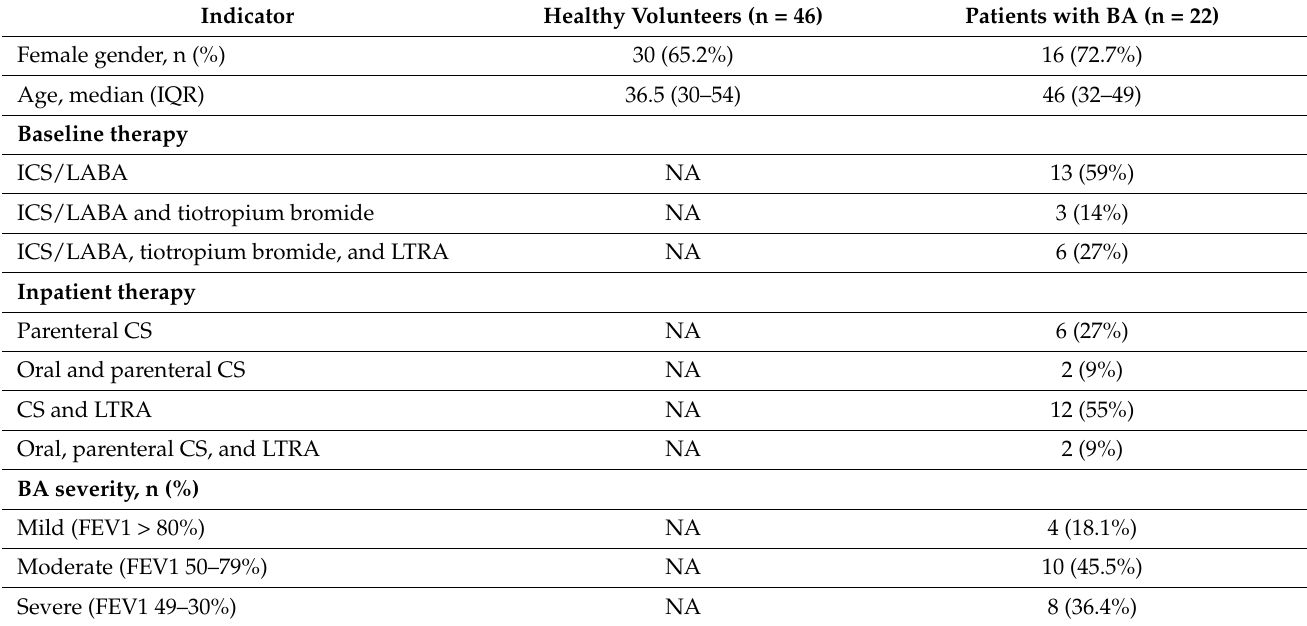
Table 1. Baseline characteristics of study